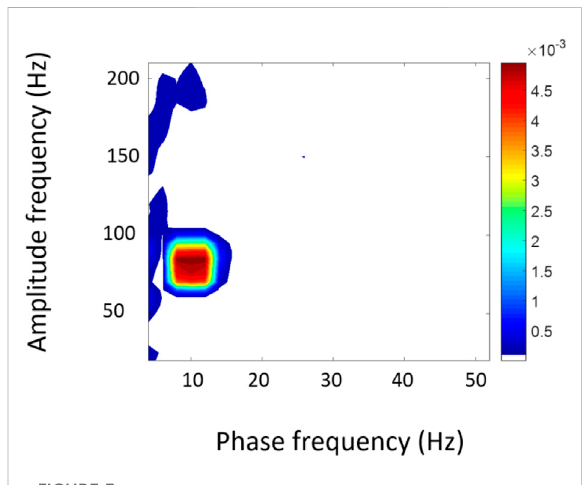
FIGURE 3 Causal map revealing the phase-amplitude coupling for the signalgeneratedbyEqs9,10.Thecolour coderepresentsthelevel of coupling derived with the conditional mutual information CMI. The position of the central spot in the CMI map indicates the coupling between the slow oscillation phase (10 Hz) with the amplitude of the faster rhythm (80